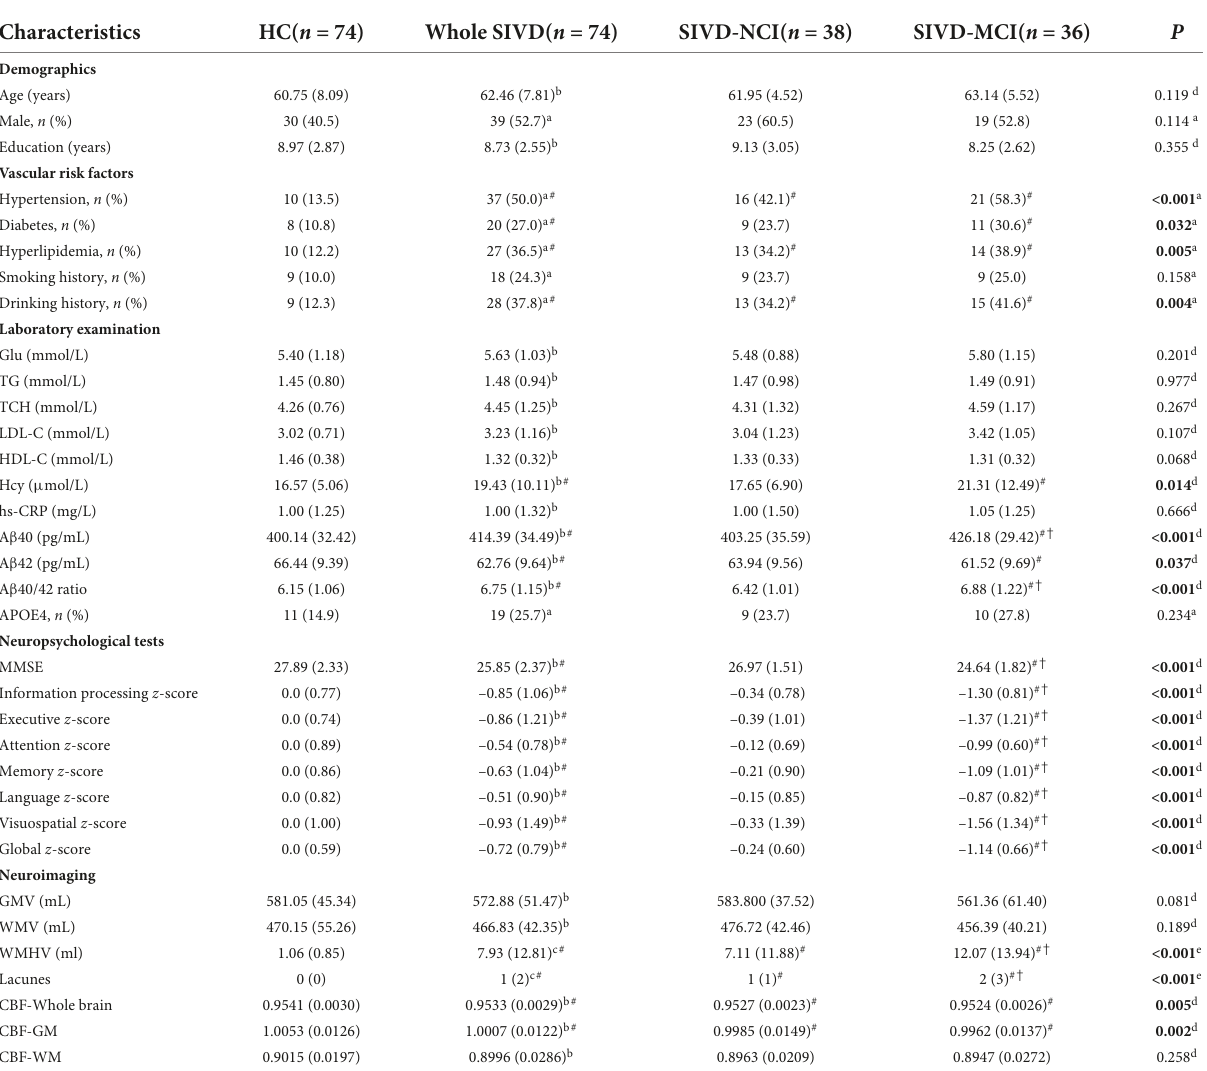
TABLE 1 Demographic, clinical, and neuroimaging manifestations data.